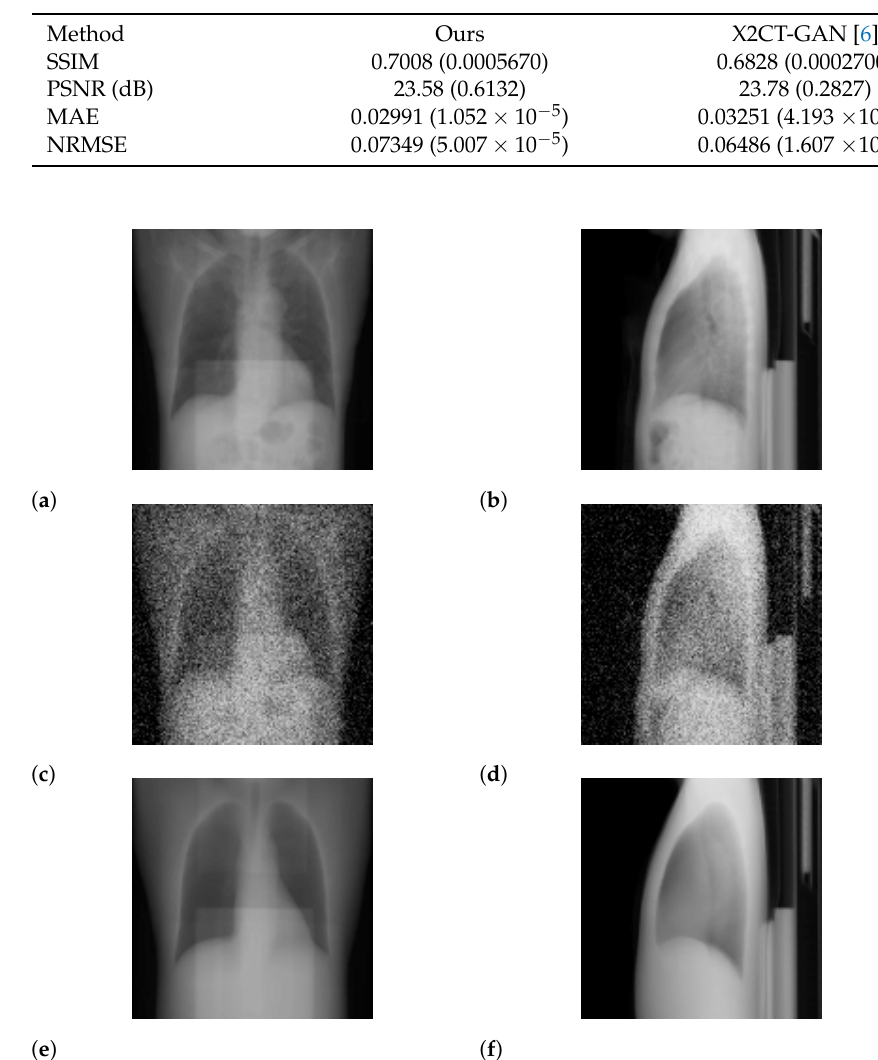
Figure 7. Input images and projections of a reconstructed image ( N = 2): ( a , b ) projections of the ground-truth image, ( c , d ) noisy input 2D images assuming an ultra-low-dose protocol, ( e , f ) pro- jections of the optimum reconstructed image. The intensities of these images were modified to enhance